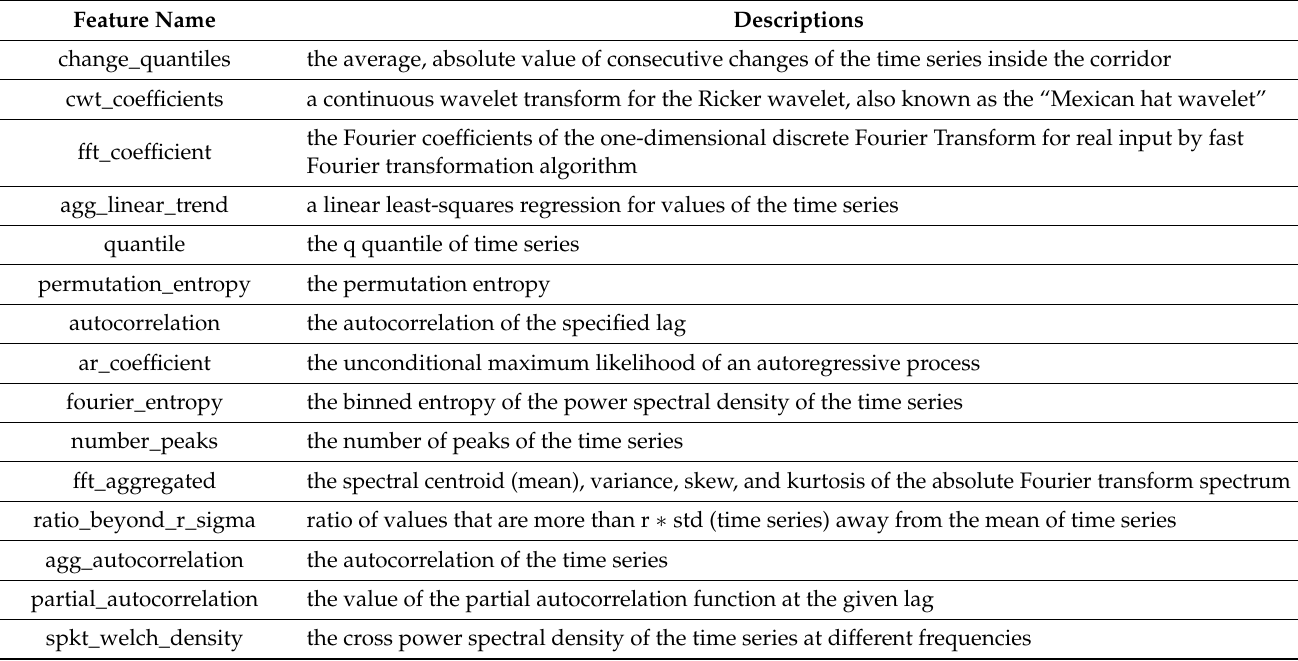
Table 3. Examples of selected common features based on the feature significance test. Feature names were adopted from [54].